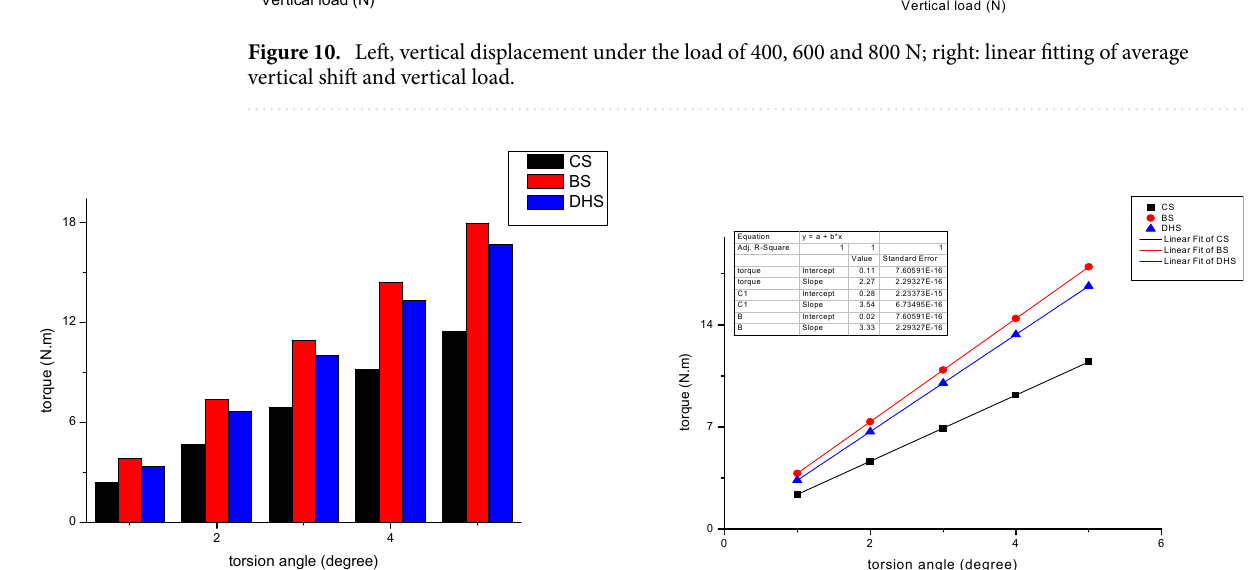
Figure 11. Left, torque under torsion angle of 1–5°; right: linear fitting of torque and torsion